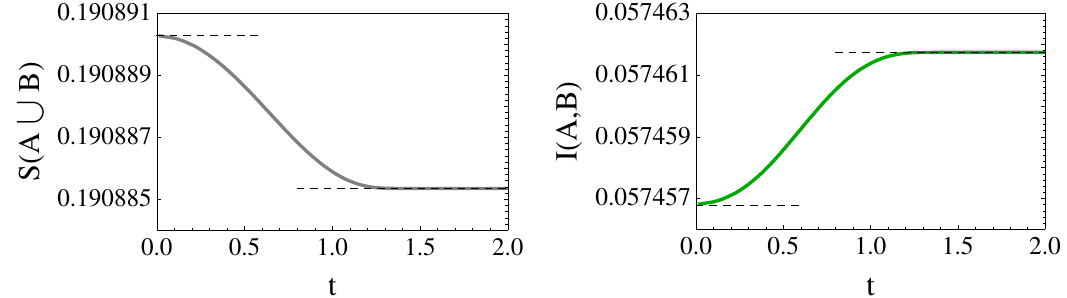
Figure 8 . (Left) Renormalized entanglement entropy of A [ B as a function of time, see (cid:12)gure 4. (Right) Mutual information of A and B as a function of time. In these (cid:12)gures the (dashed) horizontal lines correspond to the results by using the analytical formulas, equations (3.15), (3.16) and (3.17). The intervals correspond to x 1 2 [ (cid:0) 0 : 175 ; 0 : 175] and x 2 2 [ (cid:0) 1 : 35 ; 1 : 35], and temperatures T L = 0 : 2 and T R = 0 : 195. We have set G = 1 and L =